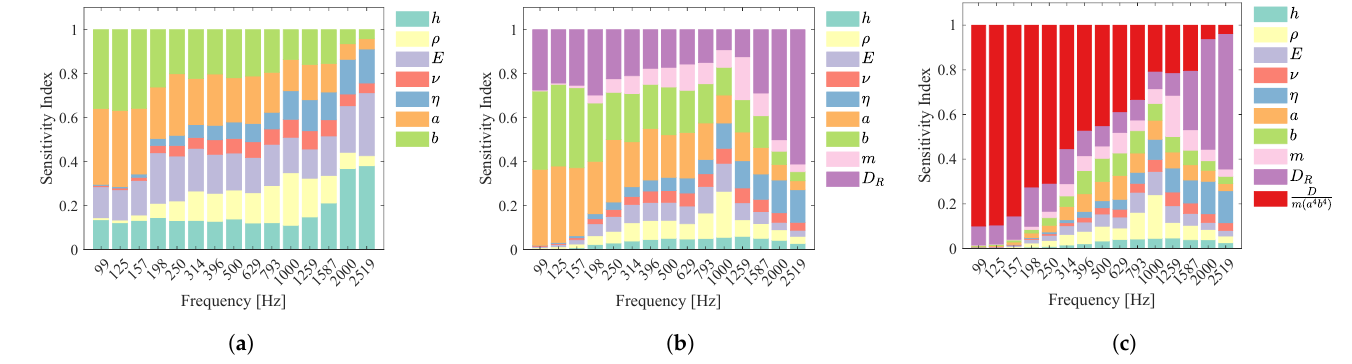
Figure 10. MDI-based sensitivity of the 1/3 octave band average STL of finite plates evaluated by modal summation (MS): ( a ) the inputs of the surrogate only consist of the STL variables ( RMSE = 2.19 ± 0.05 dB); ( b ) physics-guided features m and D R are included as input for the sur- rogate ( RMSE = 2.01 ± 0.02 dB); ( c ) physics-guided features m , D R and R are included as input for the surrogate ( RMSE = 1.49 ± 0.02 dB).